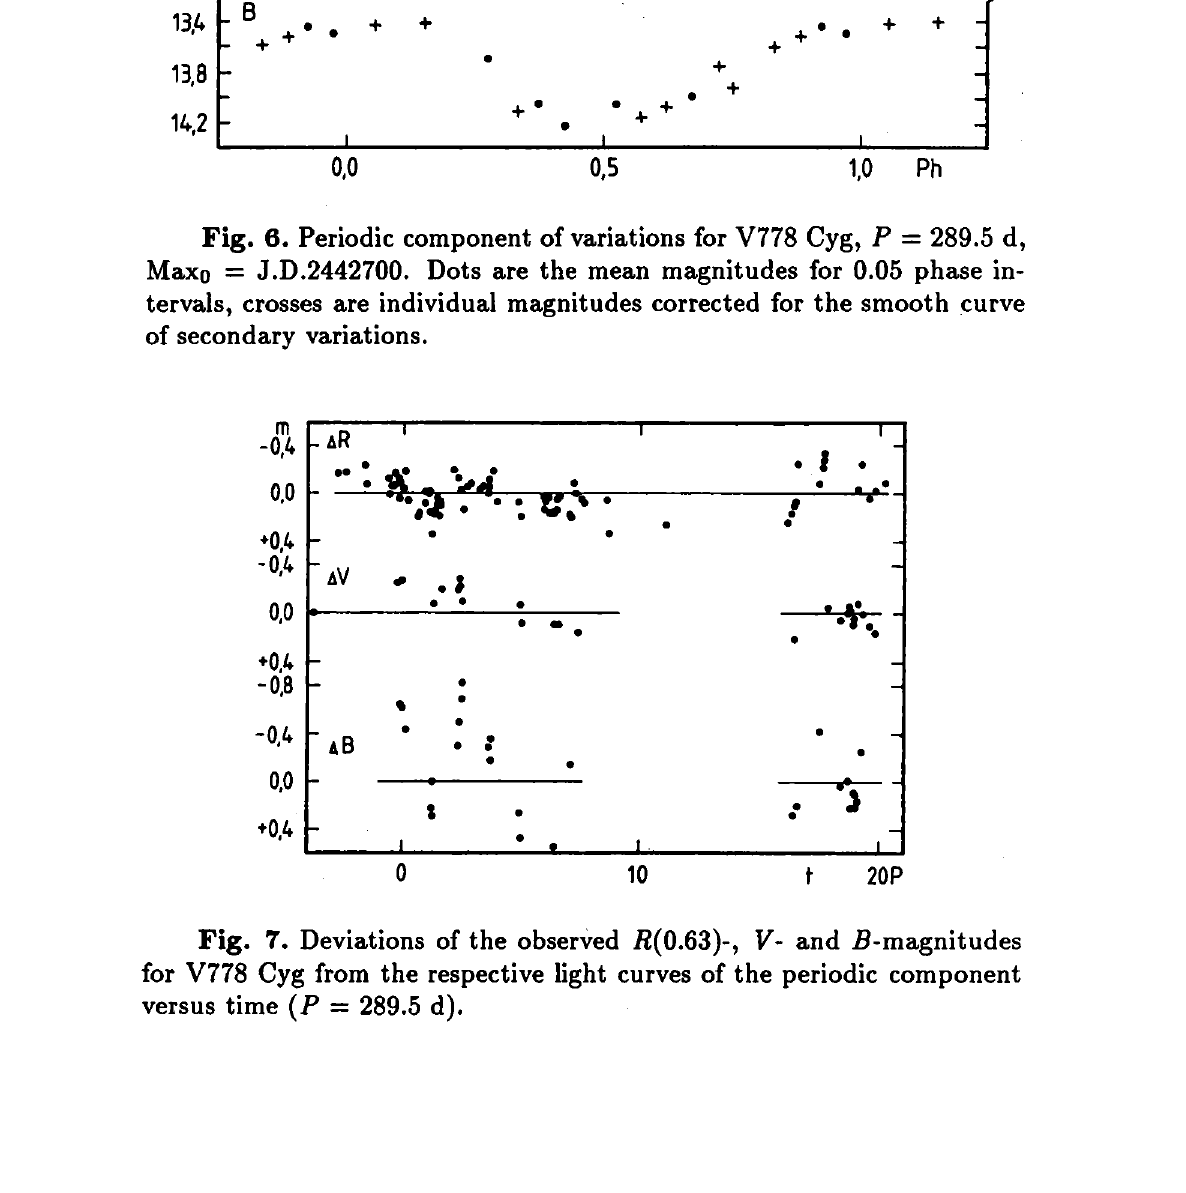
Fig. 6. Periodic component of variations for V778 Cyg, Ρ = 289.5 d, Maxo = J.D.2442700. Dots are the mean magnitudes for 0.05 phase in- tervals, crosses are individual magnitudes corrected for the smooth curve of secondary variations.